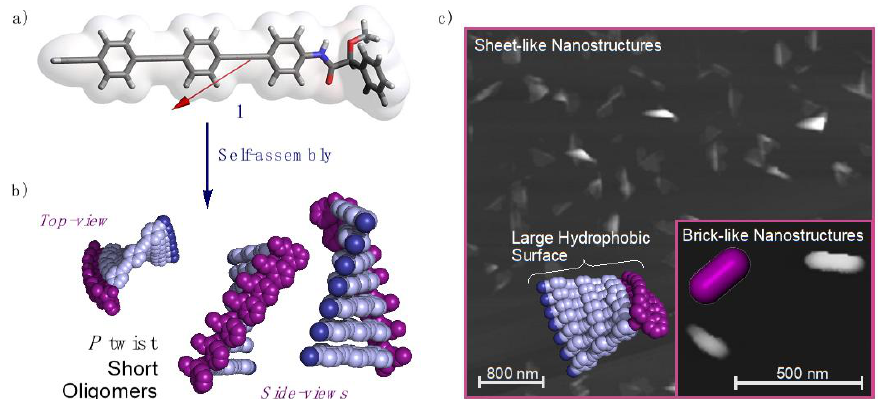
Figure 1. ( a ) Oligo(phenyleneethynylene) (OPE) [( S )- 1 ] chemical structure, dipole moment and electrostatic potential on the 0.001 au isodensity surface (vdW surface). ( b ) Supramolecular aggregate of ( S )- 1 describing a P -twisted oligomer helix. ( c ) AFM image for the obtained sheet-like nanostructures and inset of the brick-like nanostructures generated by the aggregation of several P -twisted oligomer helices.